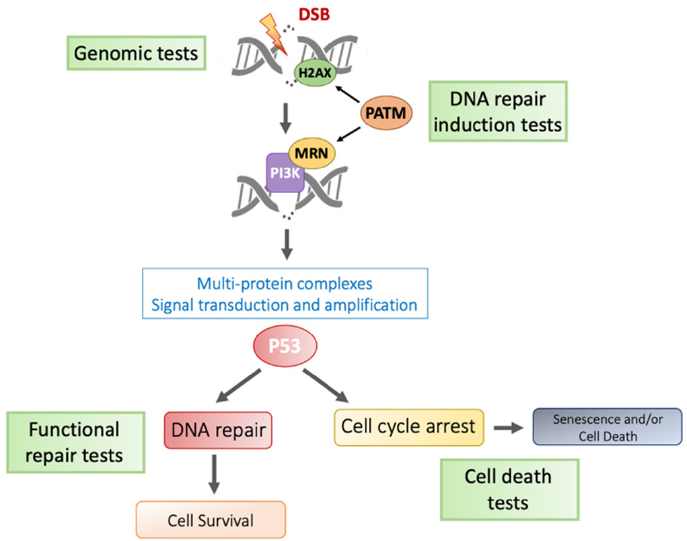
Figure 1. Main pathways involved in molecular toxicities and predictive assays.